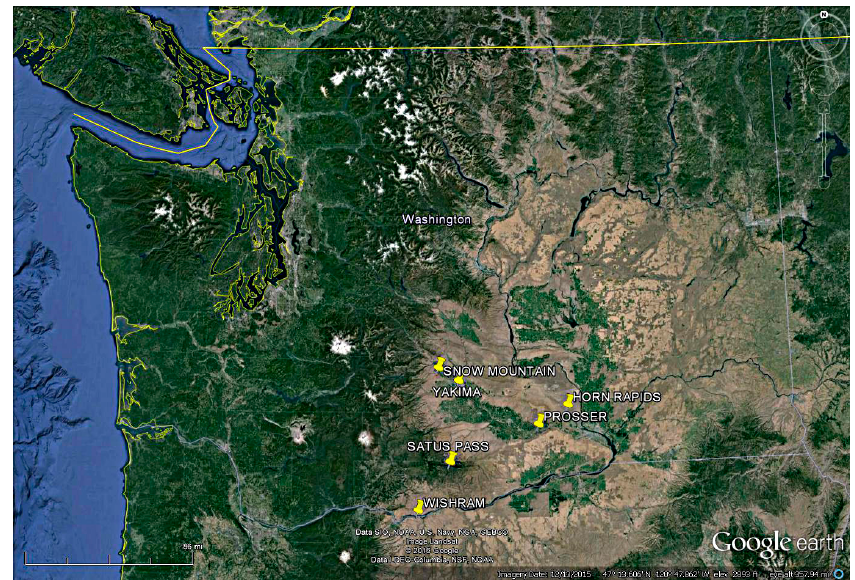
Figure 1. Washington State, WA, USA showing locations of Asclepias speciosa and Asclepias fascicularis sampled for beneficial insect attraction.